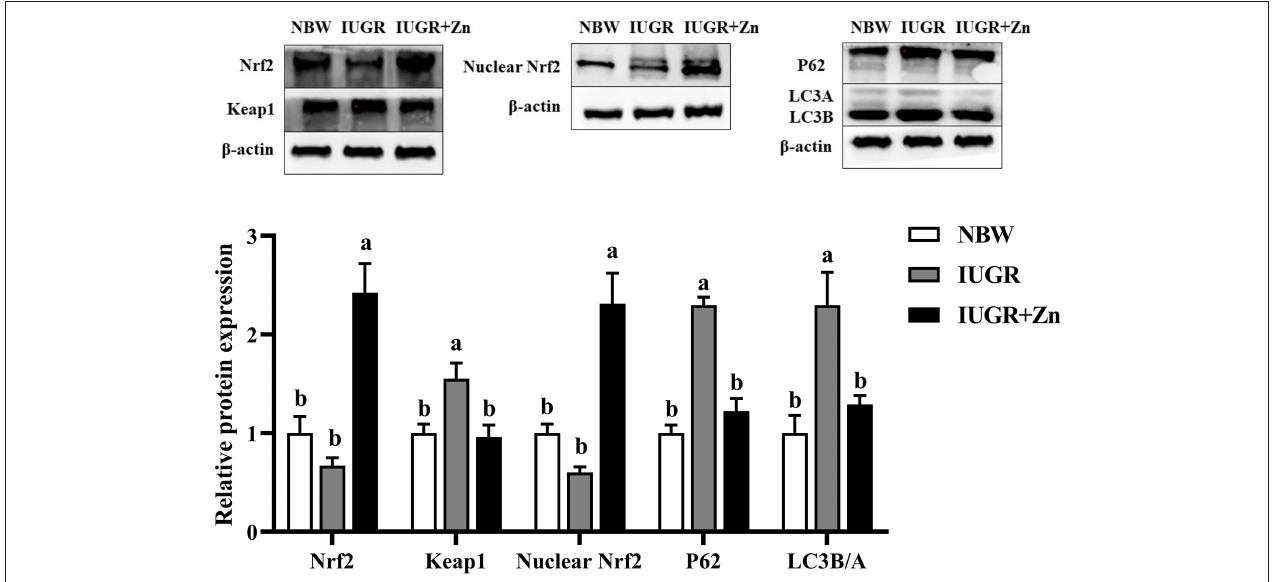
FIGURE 4 | Effects of dietary Nano-ZnO supplementation on the protein expression in jejunal mucosa of IUGR finishing pigs. Data were expressed relative to β -actin and normalized to the NBW group, and expressed as means with their SEM ( n = 4). a,b Means for the same parameter with different superscripts are significantly different ( P < 0.05). Nrf2, nuclear respiratory factor 2; P62, Sequestosome 1; LC3B/A, microtubule-associated protein light chain 3 B/A. NBW, normal birth weight pigs; IUGR, intrauterine growth restriction pigs; IUGR + Zn, IUGR pigs fed with diets supplemented with 600mg Zn/kg from